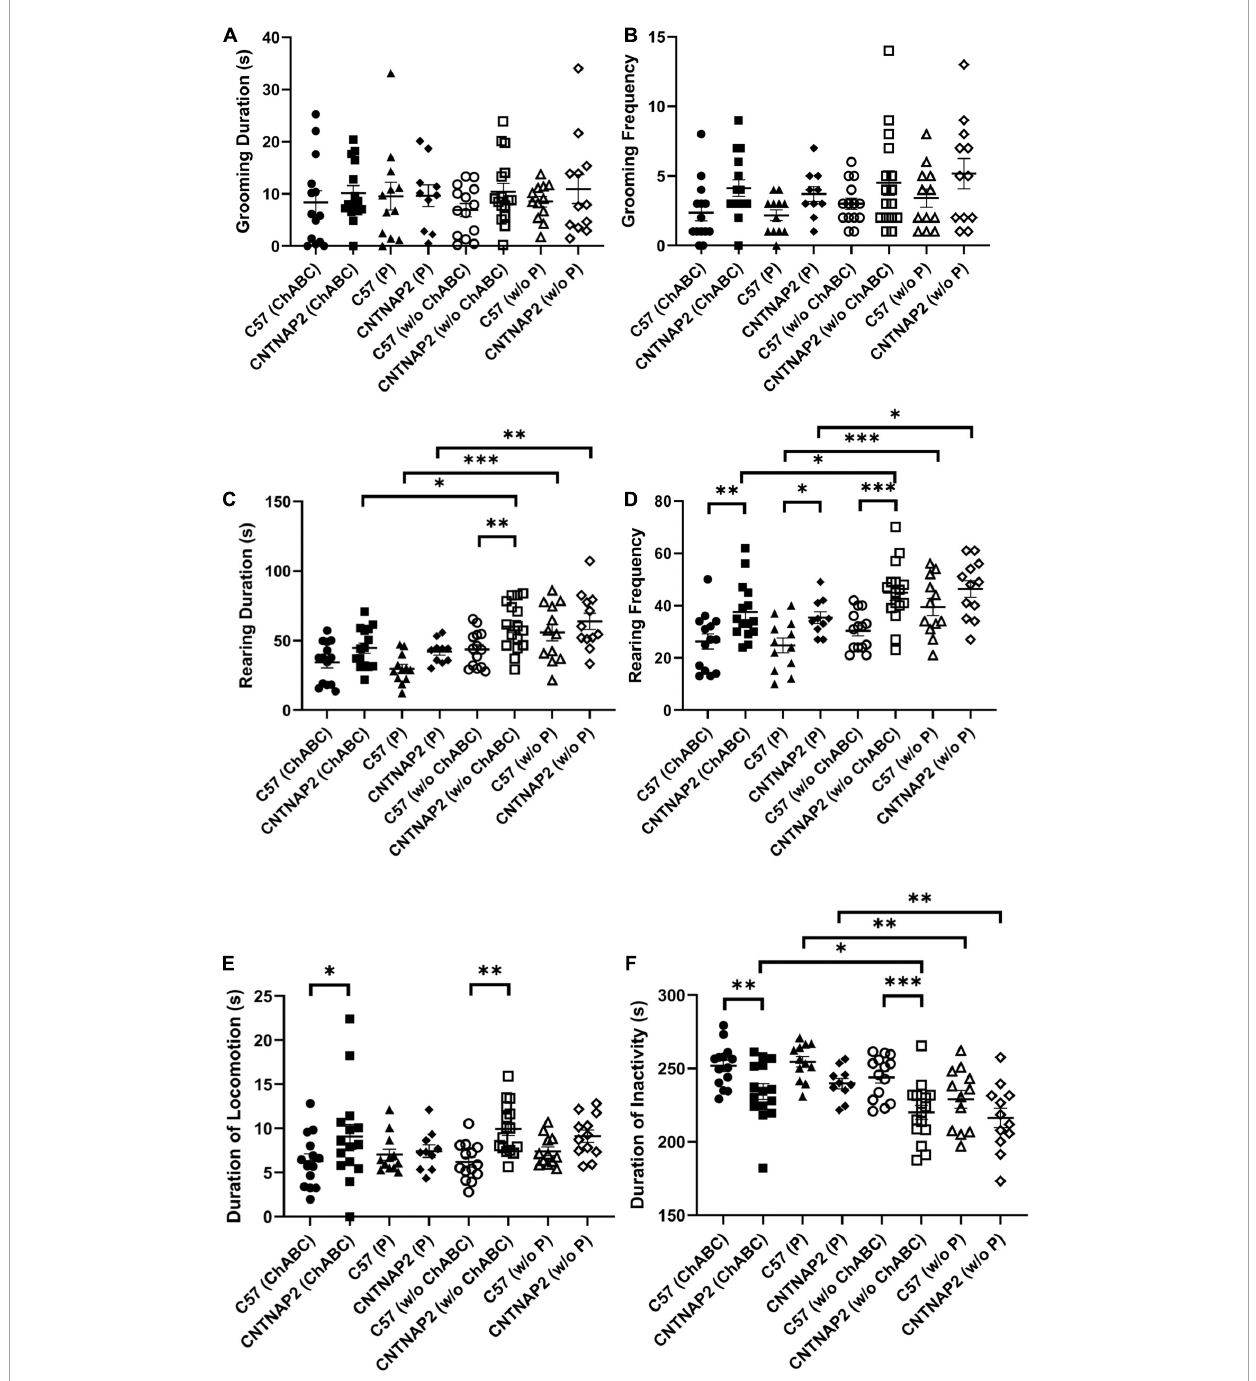
FIGURE3 Analysis of repetitive grooming and rearing behaviors following ChABC and penicillinase injections. (A–D) Behavioral analyses of grooming duration and frequency (A,B) , rearing duration and frequency (C,D) , and duration of locomotion and inactivity (E,F) in adult C57BL/6J and CNTNAP2 − / − mice treated with chondroitinase (C57BL/6J, n = 14; CNTNAP2 − / − , n = 15) and penicillinase (C57BL/6J, n = 12; CNTNAP2 − / − , n = 10). Data expressed as mean ± SEM ( p < 0.05) ( p < 0.1). Mixed ANOVA and Fisher LSD post-hoc comparisons were performed with 3-way interactions (A: F 1 , 49 . 3 = 0.02, p = 0.8868; B: F 1 , 48 . 9 = 0.08, p = 0.7722; C: F 1 , 50 . 2 = 0.67, p = 0.4171; D: F 1 , 50 . 3 = 0.81, p = 0.3728, E: F 1 , 50 . 7 = 0.02, p = 0.8750, F: F 1 , 50 . 2 = 0.34, p = 0.5605). Significance levels ( ∗ , ∗∗ , ∗∗∗∗ ) are as noted in the Methods.